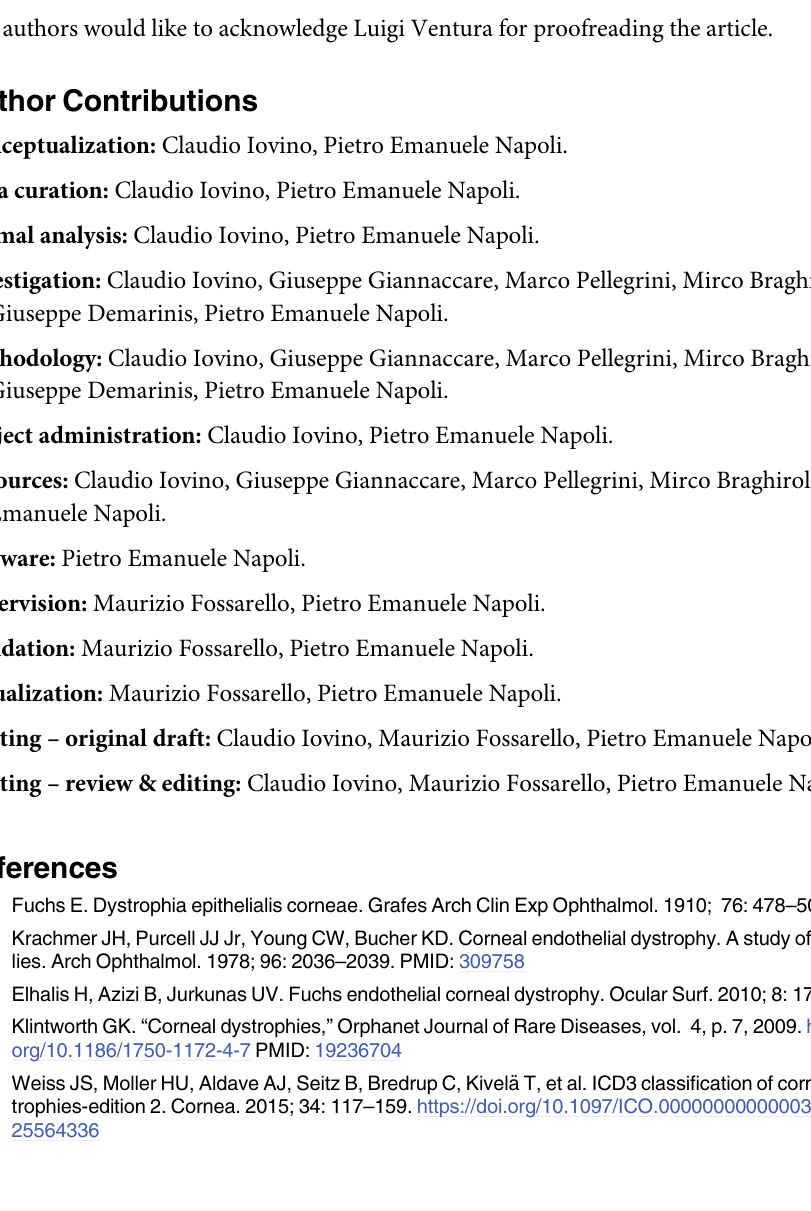
S2 Table. Data set of healthy participants